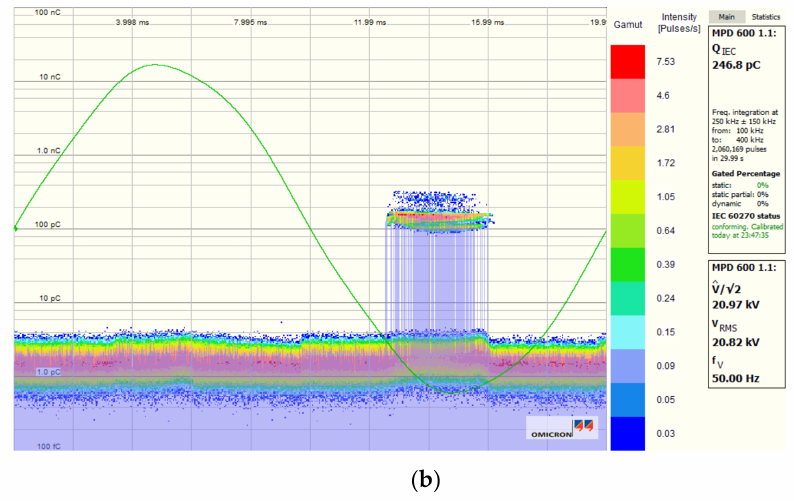
Figure 12. PD measurement results of sample A: ( a ) before and ( b ) after the 21st